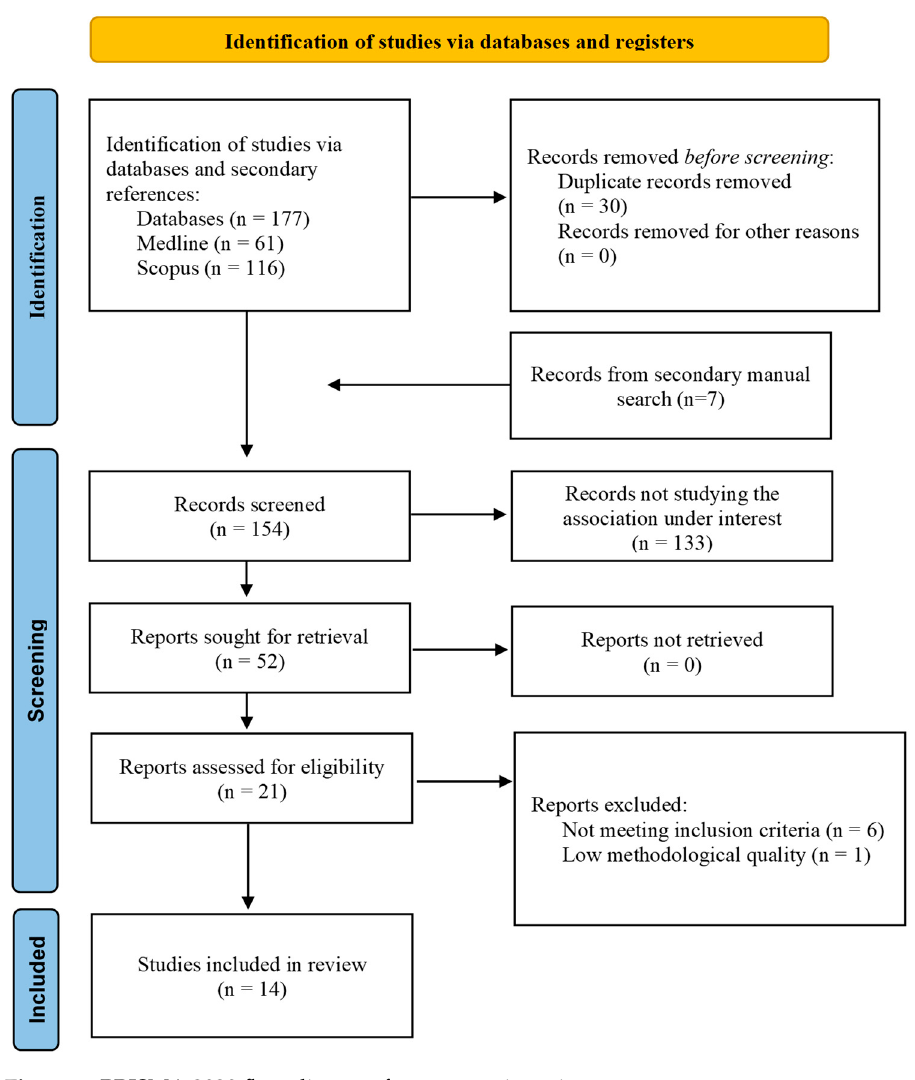
Figure 1. PRISMA 2020 flow diagram for systematic reviews.